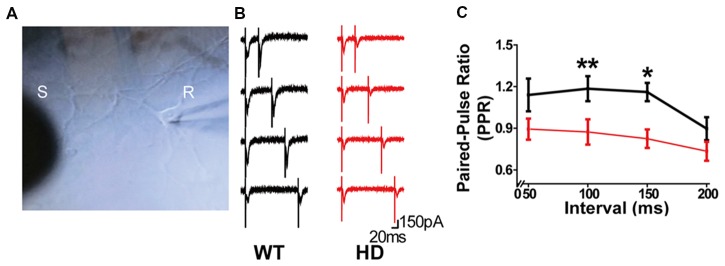
Synapses in HD cortical neurons exhibit paired-pulse depression. (A) Example image of cultured cortical neurons, showing the stimulating electrode (S) and recording electrode (R). (B) Representative traces of evoked excitatory postsynaptic currents (eEPSPs) recorded in WT and HD cortical neurons. From top to bottom, the interval between the two stimuli was 50, 100, 150, and 200 ms. (C) The paired-pulse ratio (PPR) was measured as the amplitude of the second EPSP divided by the first EPSP and is plotted against the interval between stimuli. *p < 0.05 and **p < 0.01 [Kolmogorov–Smirnov (K-S) test; n = 15 per genotype].